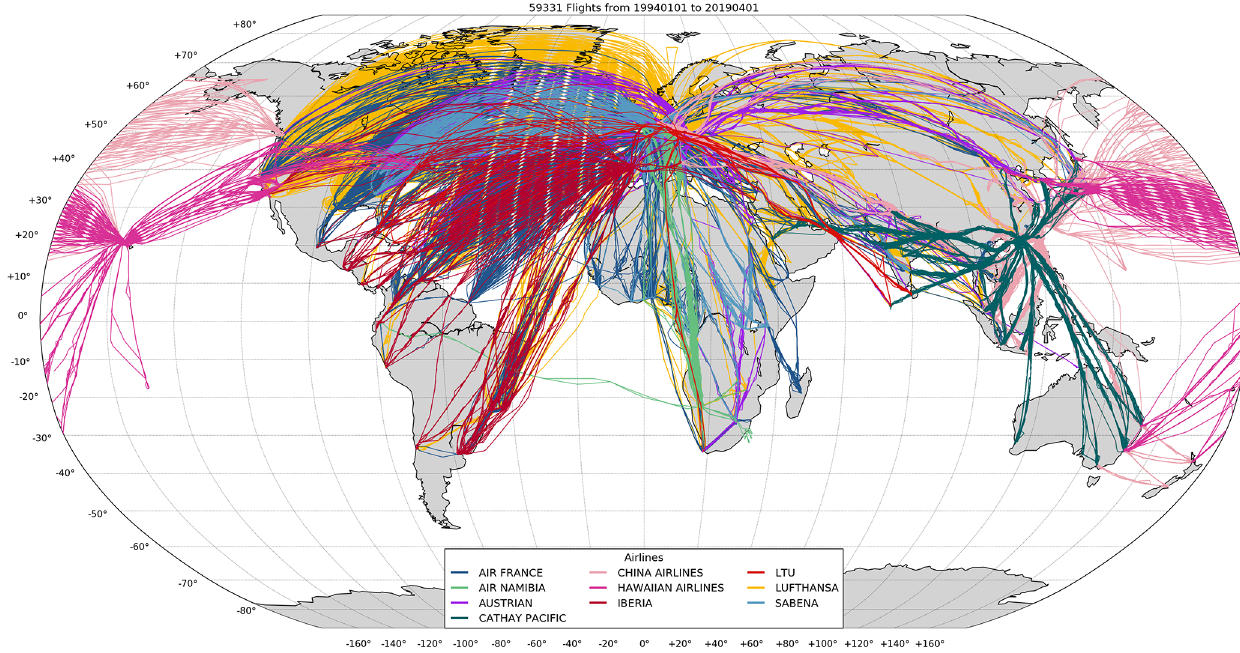
Figure 1. IAGOS aircraft fleet routes per airlines since